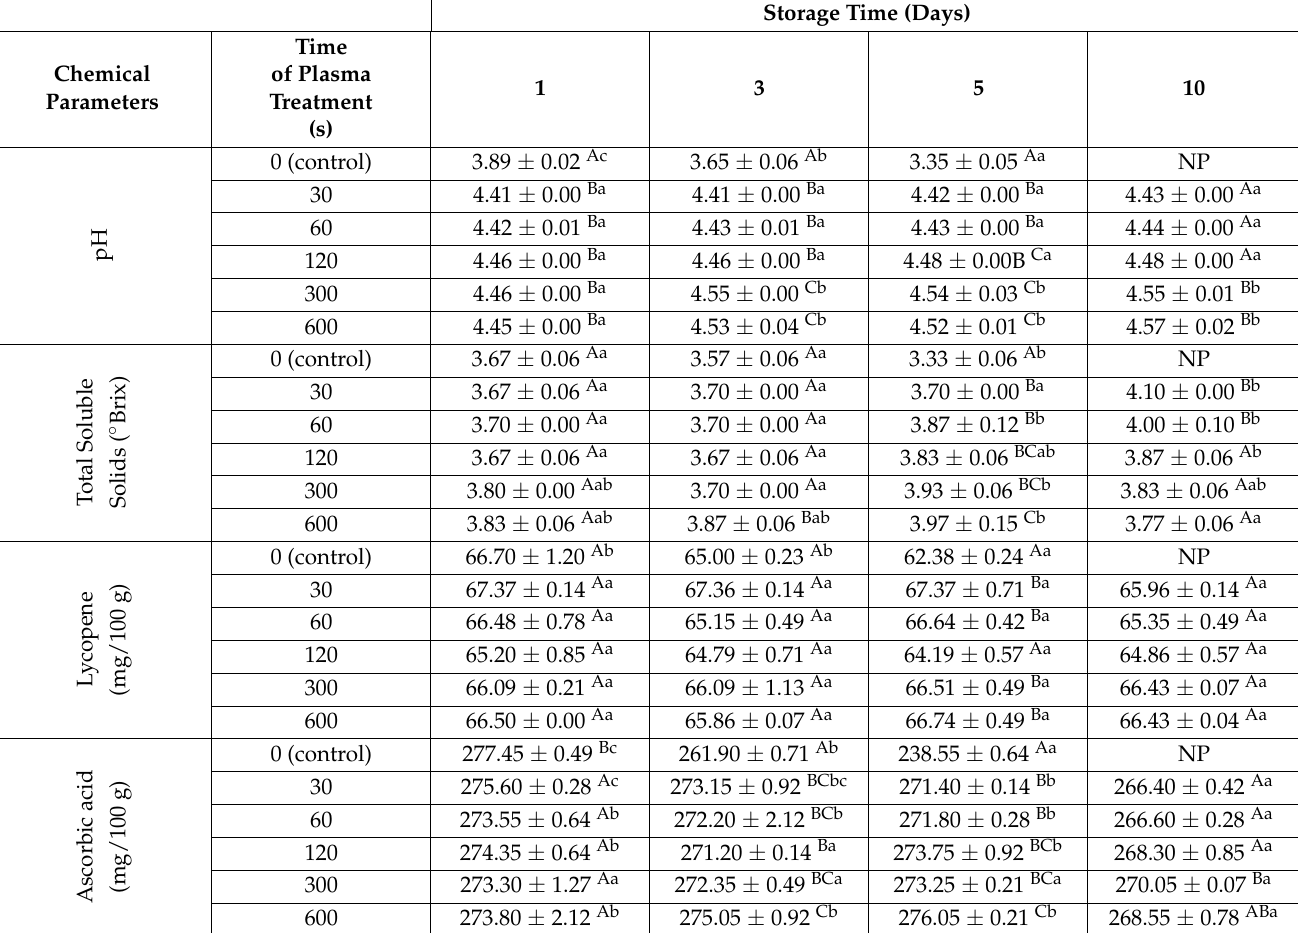
Table 1. Effect of cold plasma treatment on the chemical properties of tomato juice stored for 10 days. Storage Time